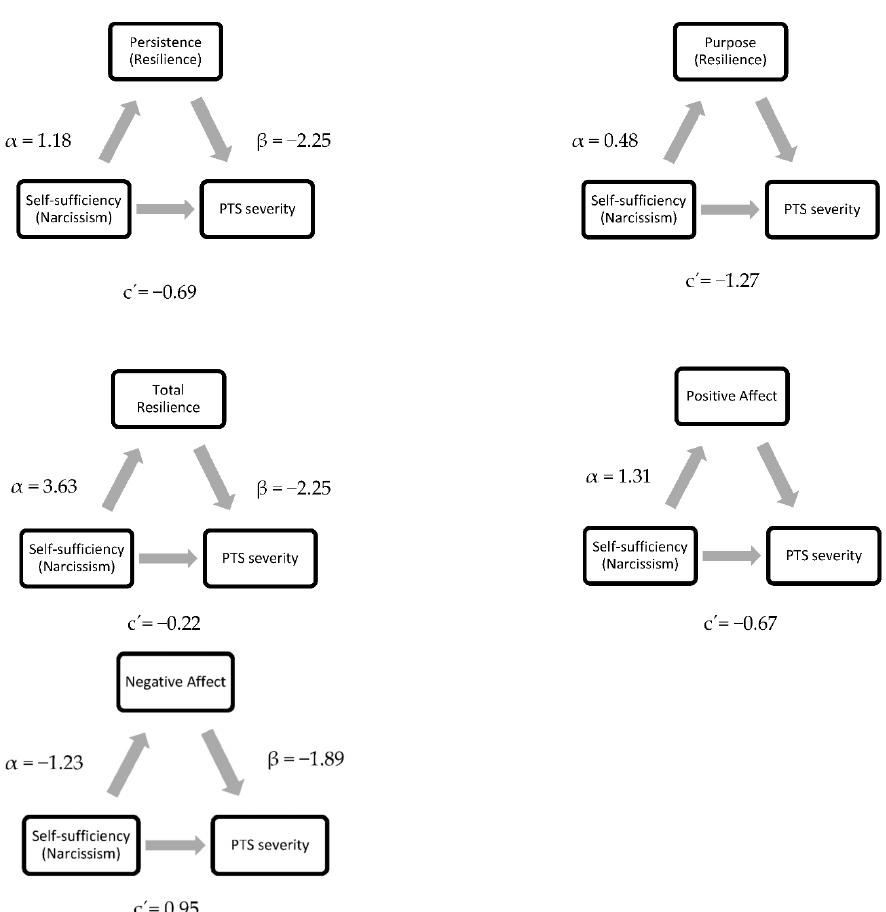
Figure 1. Statistical diagrams of partial mediation effects of positive and Negative Affect, resilience and Intolerance to Uncertainty on the relation between Narcissism and Post-traumatic symptoms (PTS; Frequency and Severity).